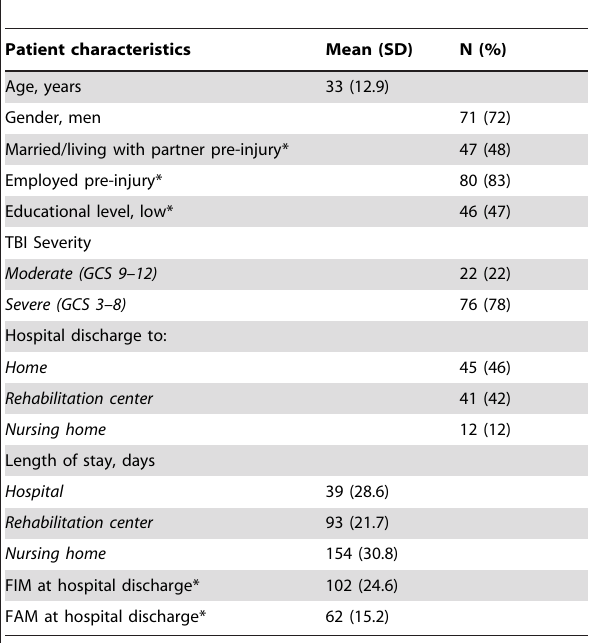
Table 1. Characteristics of patients with moderate to severe traumatic brain injury (N =98).